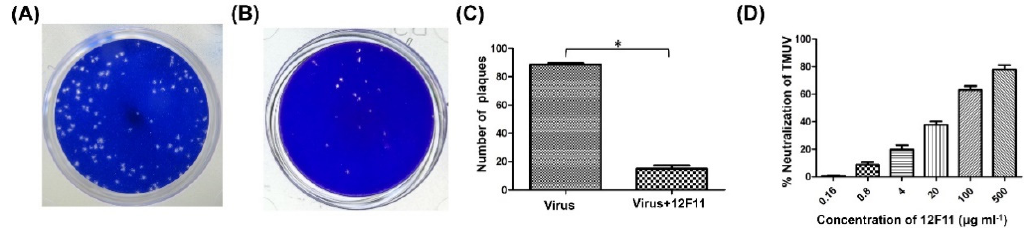
Figure 4. Evaluation of neutralizing potential of 12F11 using plaque reduction neutralization test. ( A ) Plaques formed in BHK-21 cells inoculated with TMUV Y. ( B ) Plaques formed in BHK-21 cells inoculated with TMUV Y plus 12F11 mixture. Undiluted 12F11 (500 µ g / mL, final concentration) was used. ( C ) Number of plaques counted in BHK-21 cell cultures inoculated with TMUV Y and TMUV Y plus 12F11 mixture. The results shown are mean value ± SD of three independent experiments. * p < 0.05. ( D ) Percent neutralization of 12F11 with di ff erent concentrations. The results shown are mean value ± SD of three independent experiments.